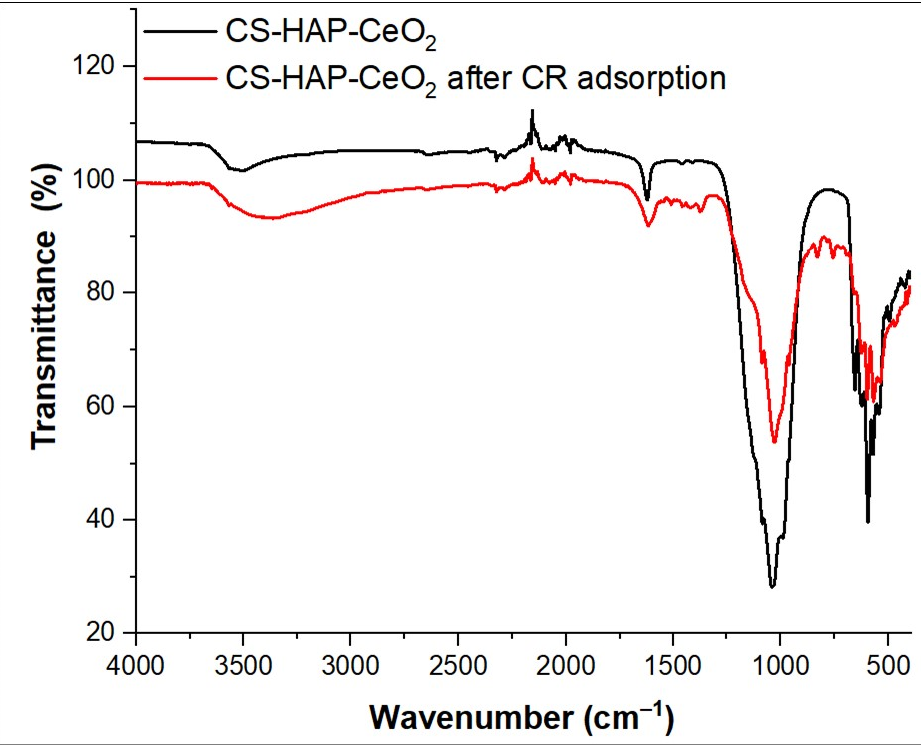
Figure 10. FTIR spectra of CS-HAP-CeO 2 heterostructure before and after CR dye adsorption.